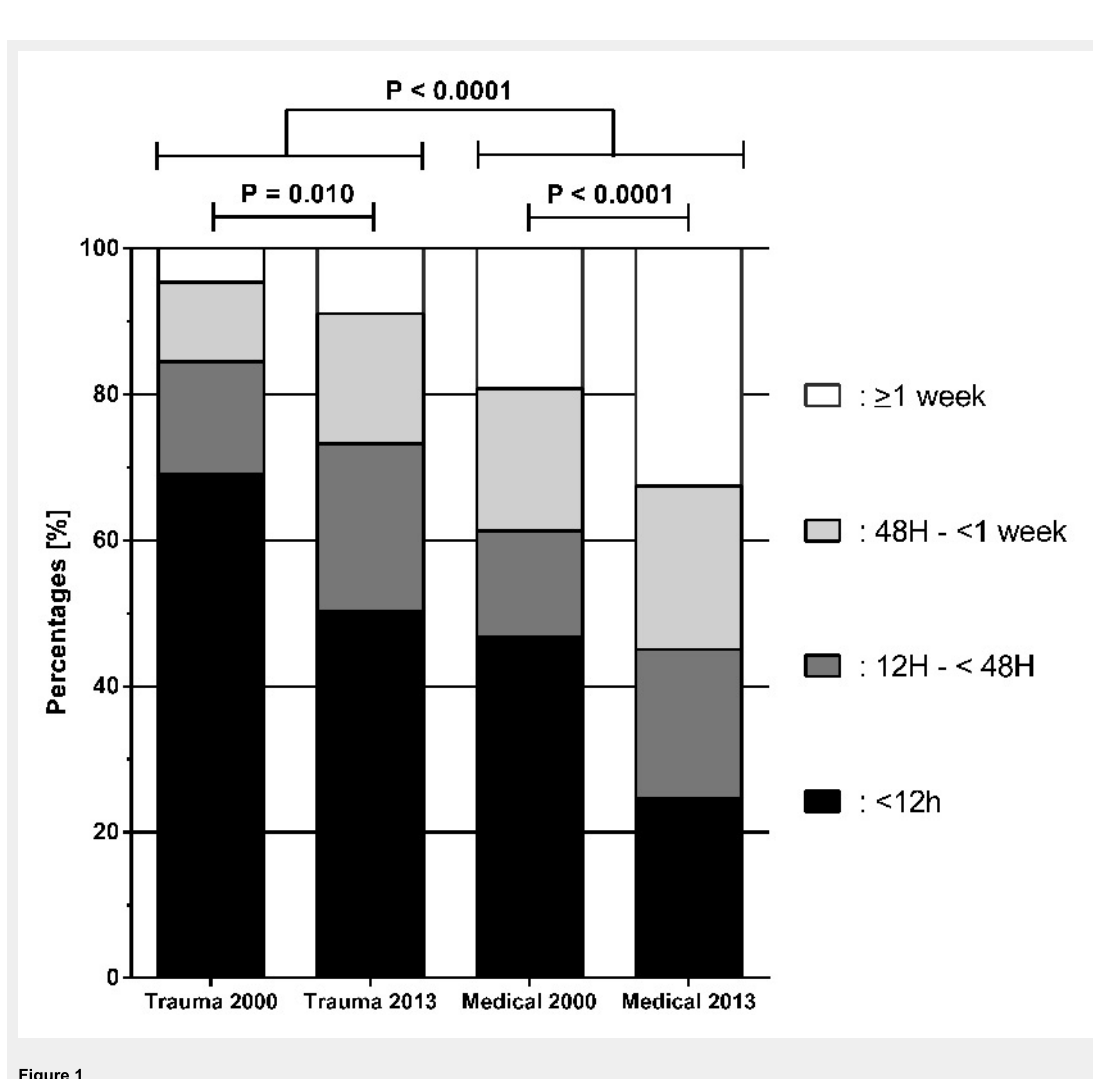
Figure 1 Time elapsed before Emergency Department consultation in 2000 and 2013, according to the type of